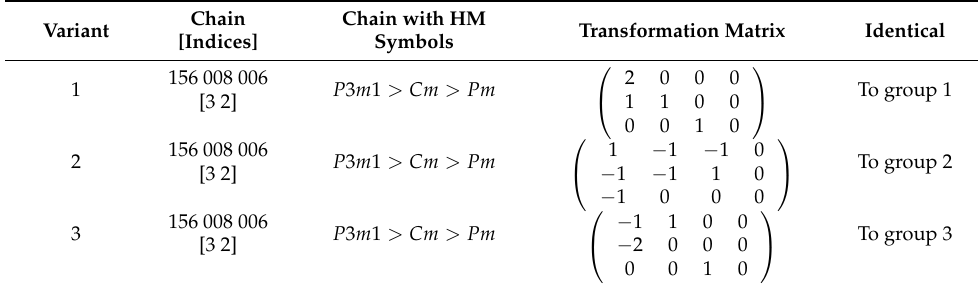
Table 2. Group-subgroup relations and transformation matrices.